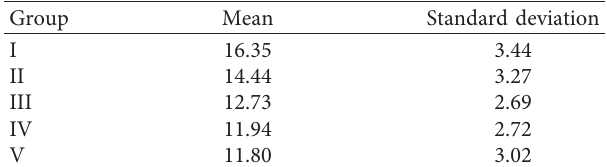
Figure 7: Average experimental point distribution of the subjects in each round. Table 10: Mean and standard deviation of points in each group of